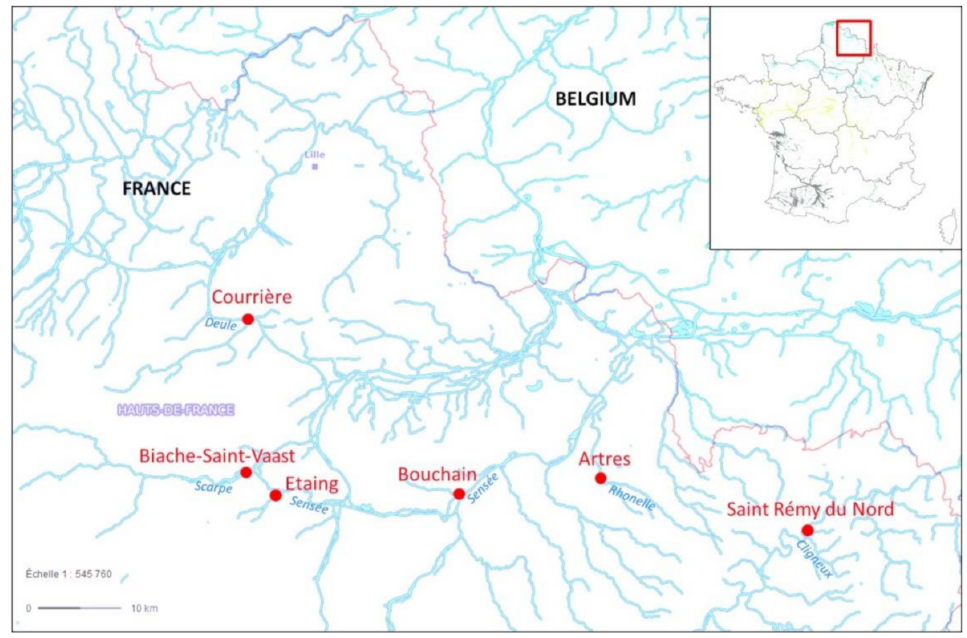
Figure 1. Location of all sampling stations investigated in the Artois-Picardie watershed, north of